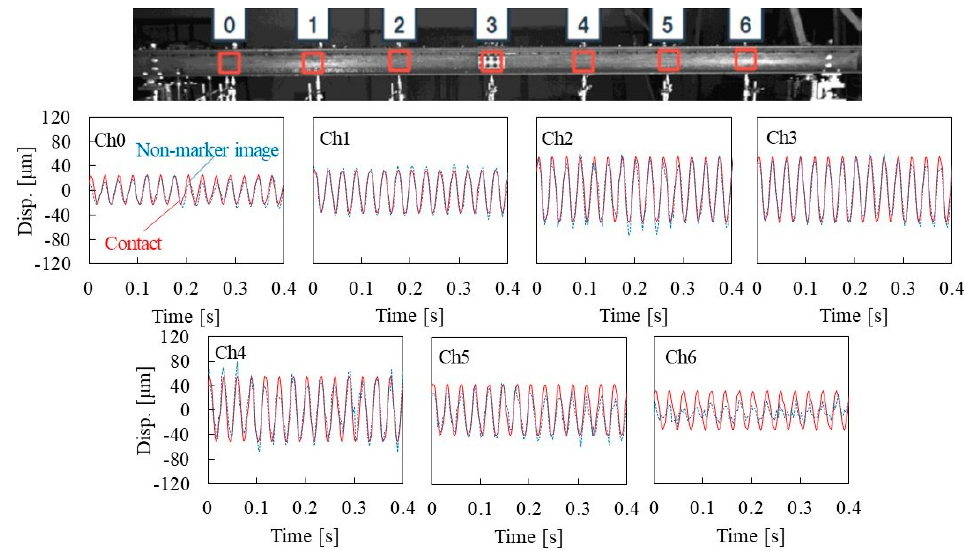
Figure 9. Comparison of displacement responses during 35 Hz excitation at the midspan.